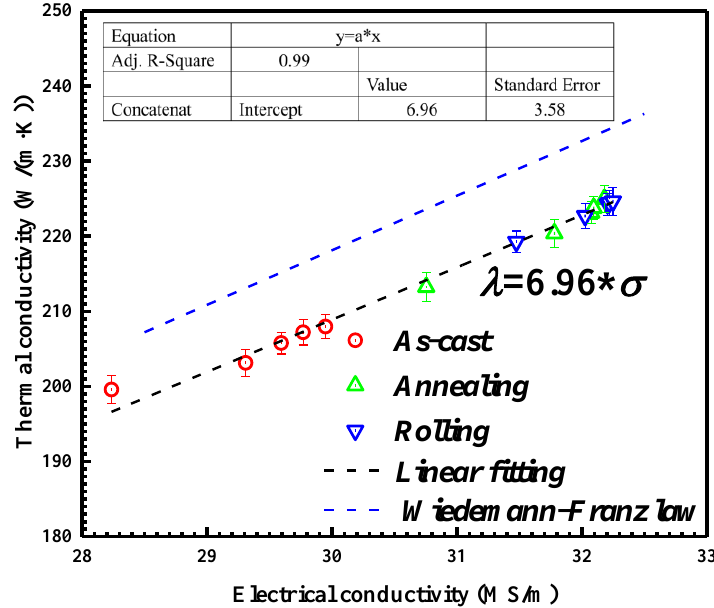
Figure 8. The linear fitting between electrical conductivity and thermal conductivity of Co-modified Al-2%Fe alloys in di ff erent states. Linear fitting (black dotted line) is conducted to match this relationship for Al-2Fe- x Co ternary alloys in the di ff erent states as shown by the black dotted